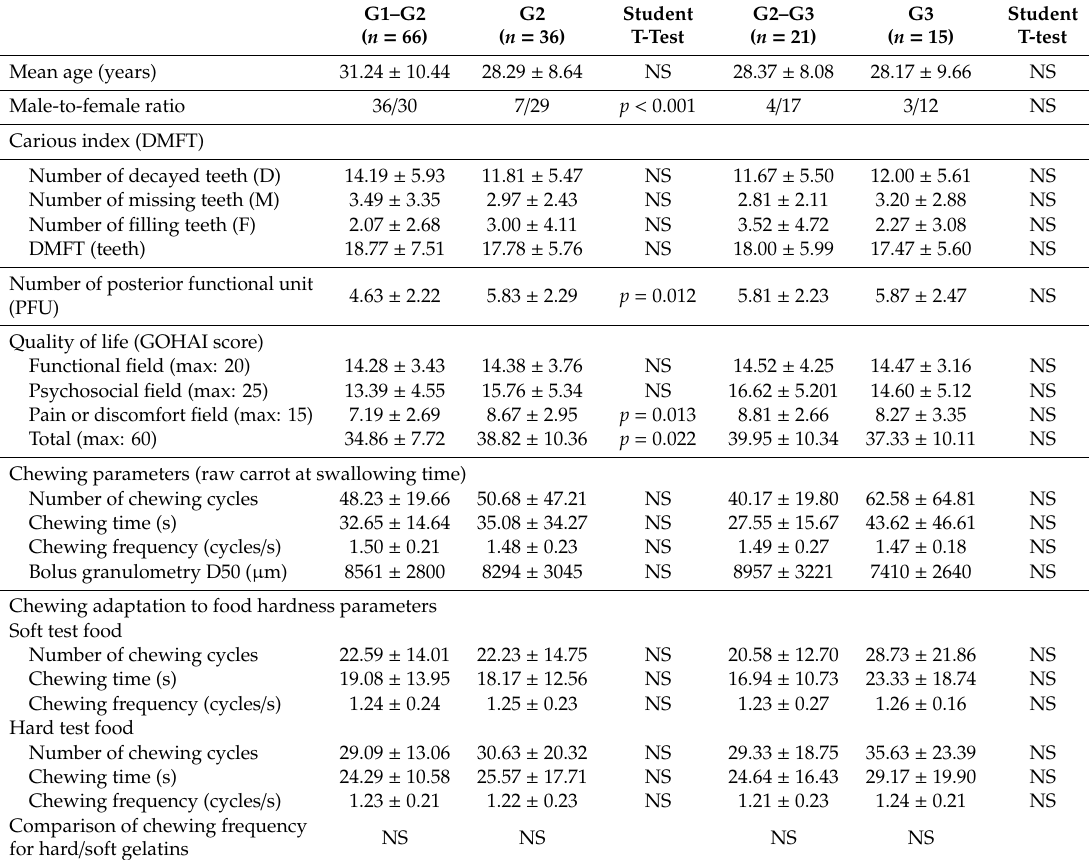
Table 3. Comparison of patients being treated at T0 but not evaluated after 1 month (G1–G2), those being treated and evaluated one month after GA (G2), those being evaluated at T2 but not at T3 (G2–G3) and those being evaluated 6 months after treatment (G3) in terms of age, sex, carious index, quality of life, and parameters of mastication before care under GA .